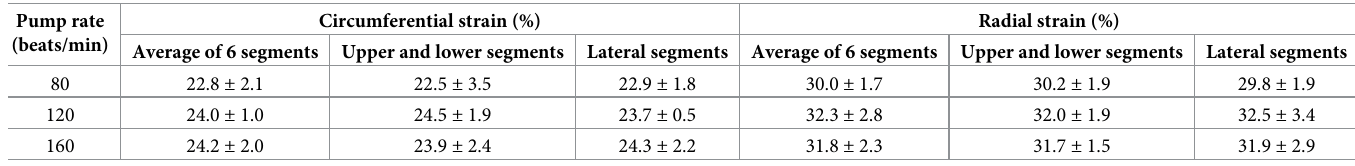
Values are expressed as mean ±